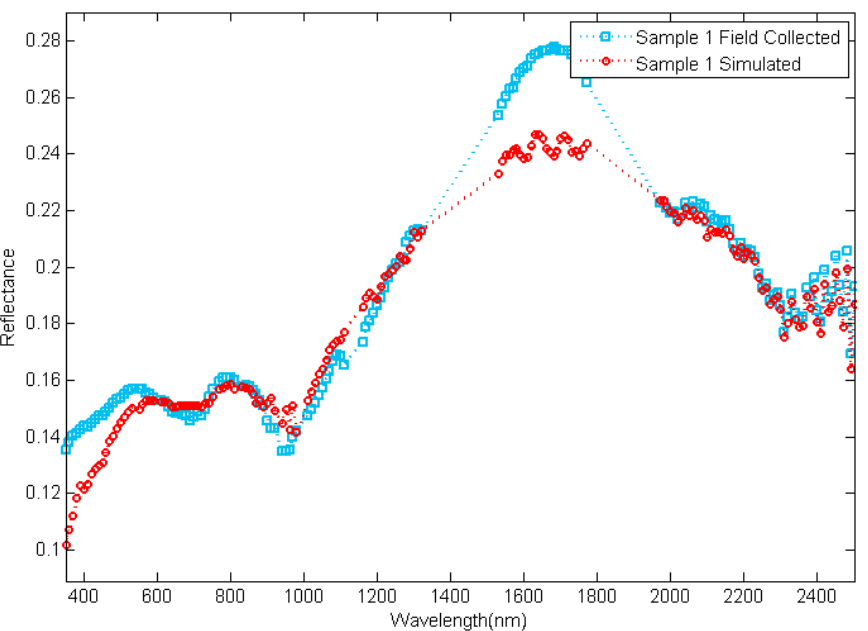
Figure 13. The reflectance collected in the field and in the skylight simulator.